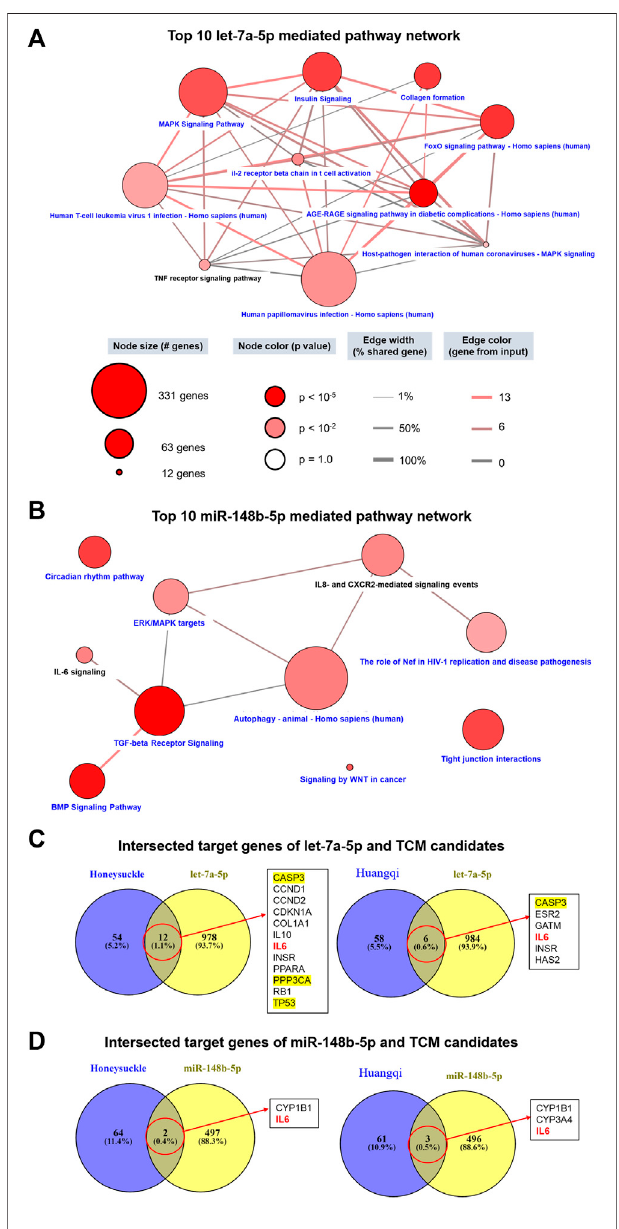
FIGURE 3 | Prediction of the functions of let-7a and miR-148b and their connections with the TCM candidates using multiple databases. miRNA- related targets were obtained from miRDB, and each list of genes (990 target genesfor let-7a-5p and499targetgenesfor miR-148b-5p )wereusedto query CPDB for signaling pathways. (A,B) show the network of 10 signaling pathways related to this study and mediated by let-7a-5p and miR-148b-5p , respectively. Pathways in black are highly related to this study. (C,D) display the intersecting target genes of miRNA and TCM candidates. Of particular interest, the MAPK pathway (yellow) and the IL6 pathway (red) are associated with cytokine storms in COVID-19 patients.